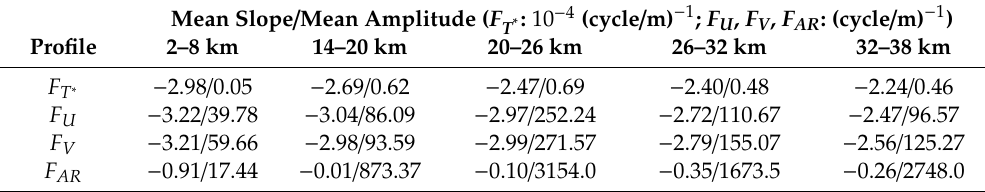
Table 2. Spectrum slope and amplitude of normalized temperature fluctuation .